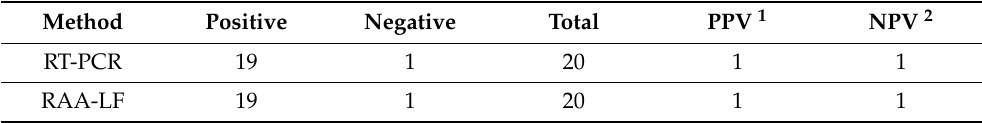
Table 3. Results of RT-PCR and RAA-LF tests using clinical